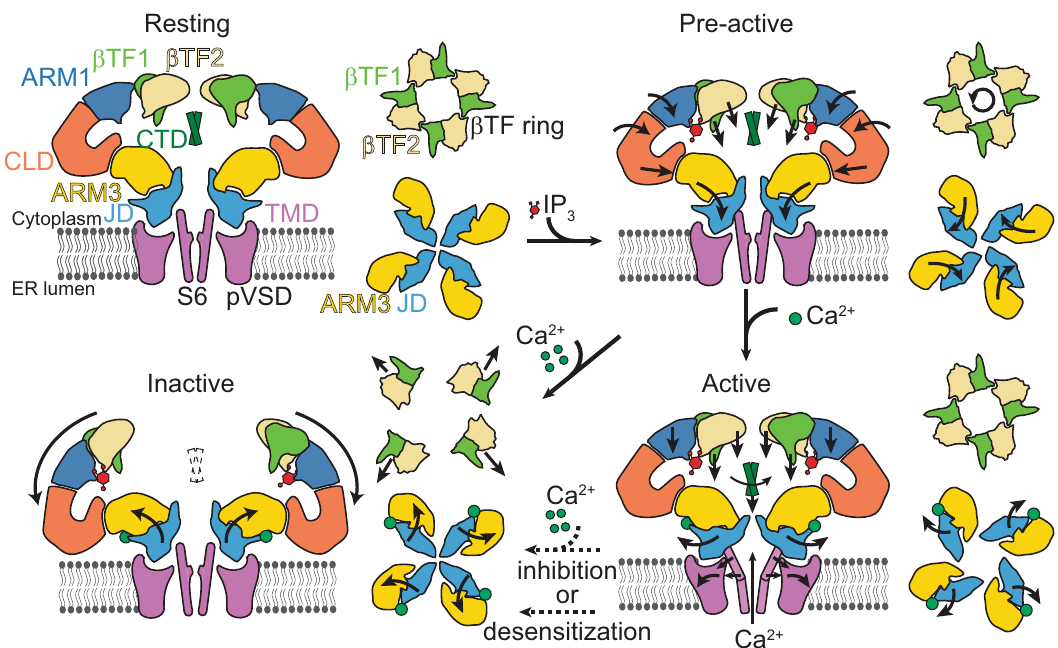
Fig. 6 Schematic representation of the IP 3 R gating cycle. A side view of the two opposing subunits (left) and cytoplasmic views of the β TFs and ARM3-JD tetramers (right) for each indicated functional state is depicted. The ARM2 and CTD are omitted for clarity. Arrows shown on the domains indicate the direction of the rotation or translation from the previous